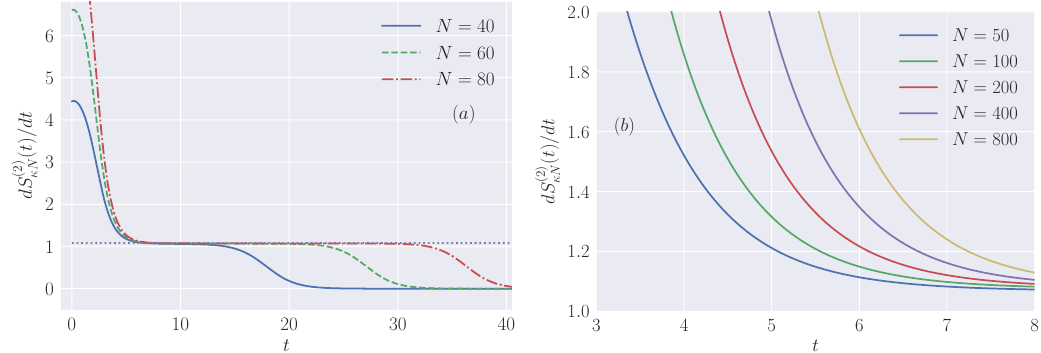
( t ) as a function of time, for (cid:20)N